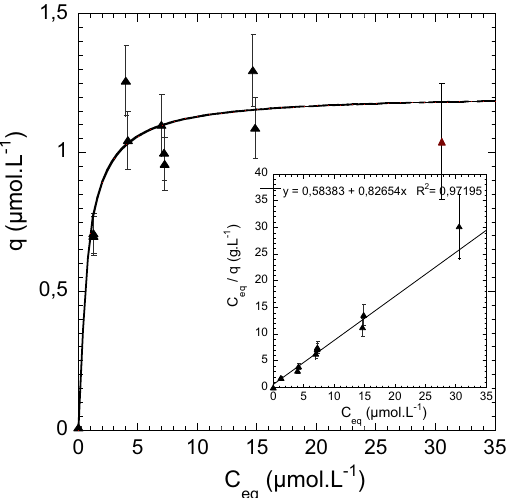
Figure 5. Adsorption isotherm of sorbed Zn(II) mass q versus Zn(II) equilibrium concentration c eq